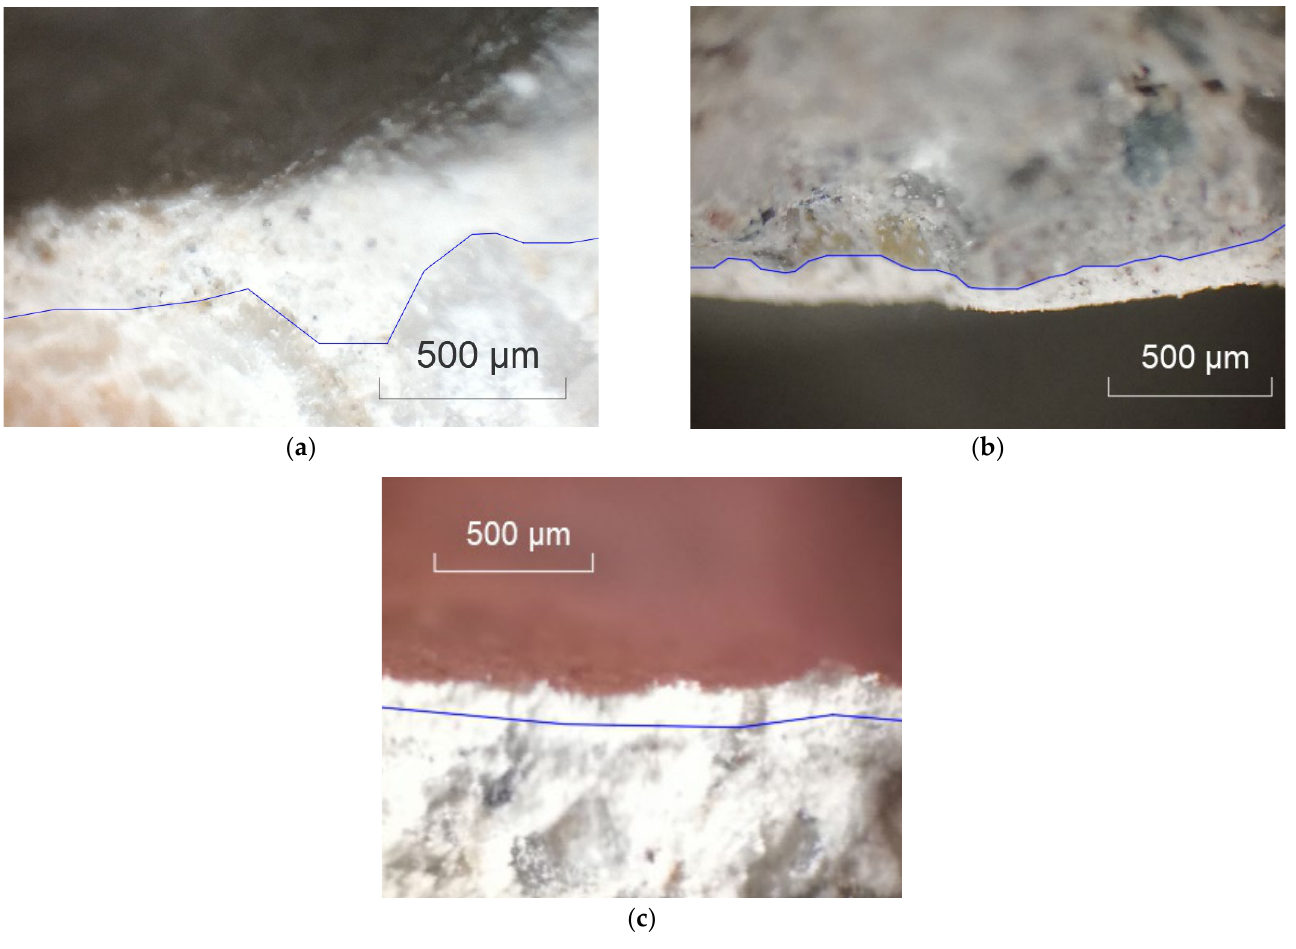
Figure 18. Cross-sections of the treated RCA (magnification: 40). ( a ) S_C0.7; ( b ) S_C1.0; ( c ) S_C1.3.